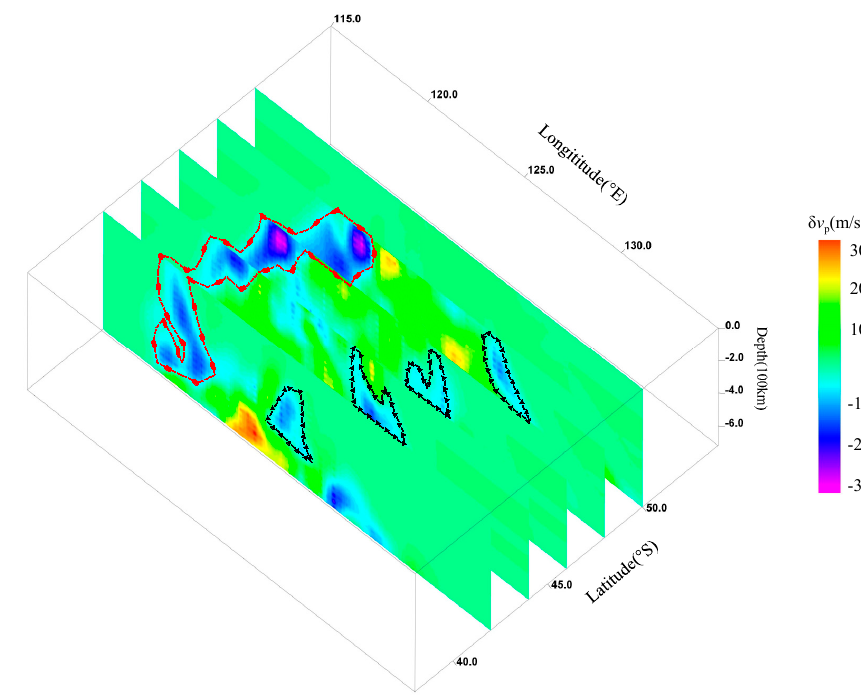
Appl. Sci. 2020 , 10 , x FOR PEER REVIEW Figure 11. Five slices in the range of 42 ◦ N–50 ◦ N from east to west. Figure 11. Five slices in the range of 42° N–50° N from east to west.